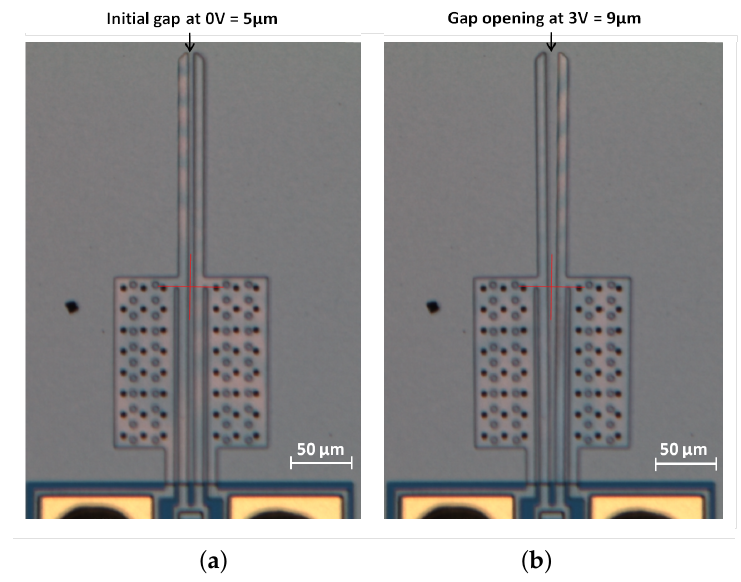
Figure 15. Optical images showing the fabricated polysilicon microgripper when not actuated ( a ), and when each arm is actuated under an applied potential of 3 V ( b ). The gap opening in the closed position is 5 µ m ( a ). A potential of 3 V applied across each microgripper arm results in a total gap opening of 9 µ m. ( b